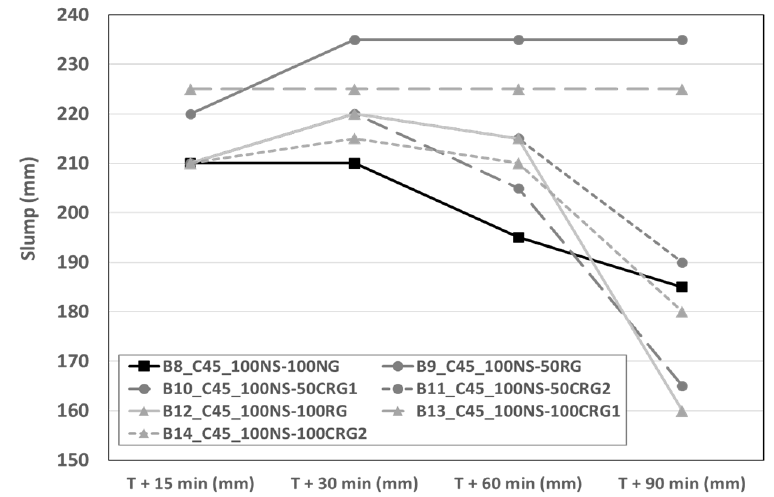
Figure 7. Measured slumps for the C45 concretes.